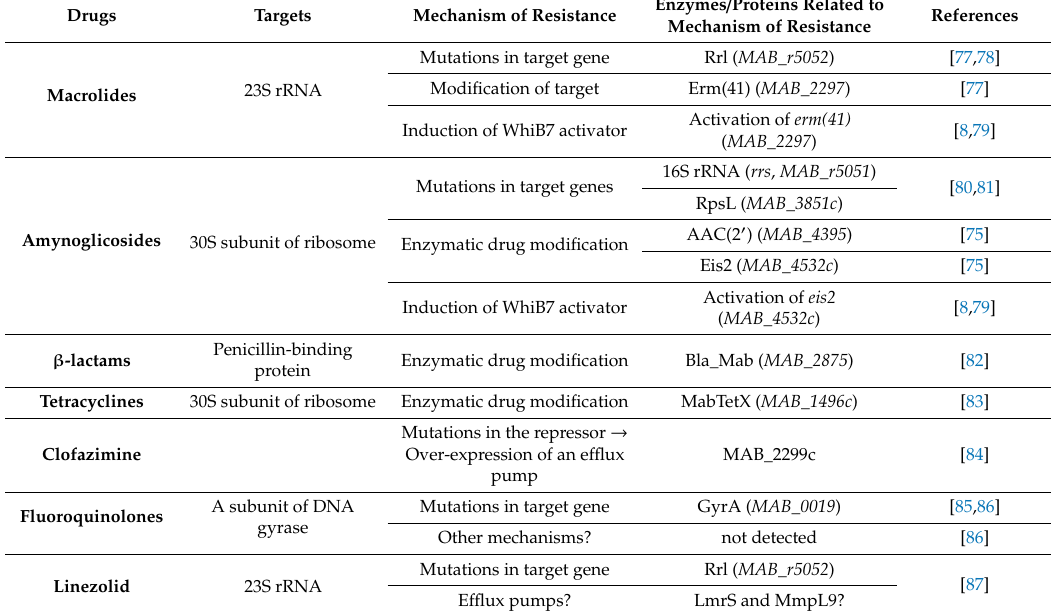
Table 1. Mechanisms of resistance to current drugs used against Mab